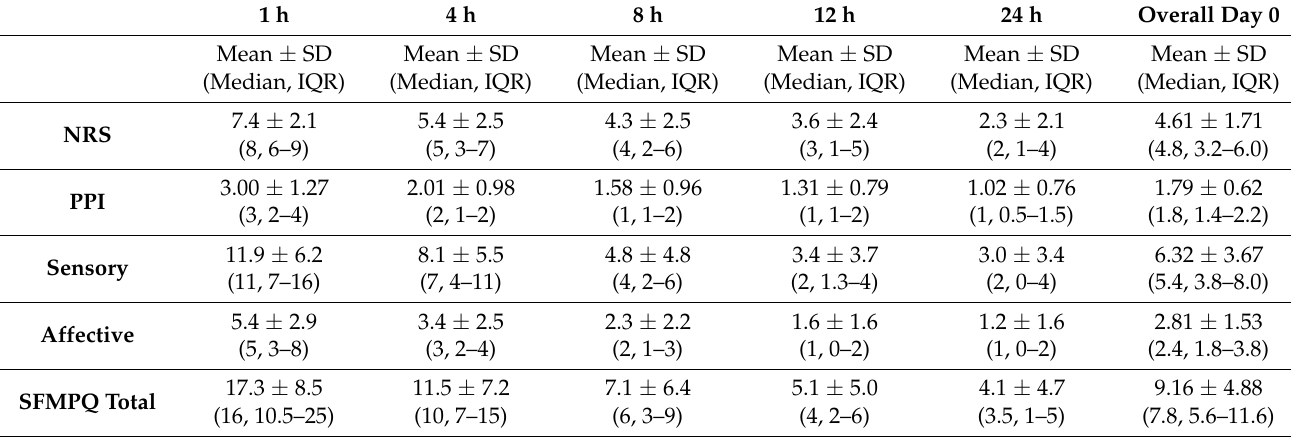
Table 3. McGill Pain Questionnaire Short Form (MPQ-SF) parameters for every predetermined time point and during the first 24 postoperative hours.